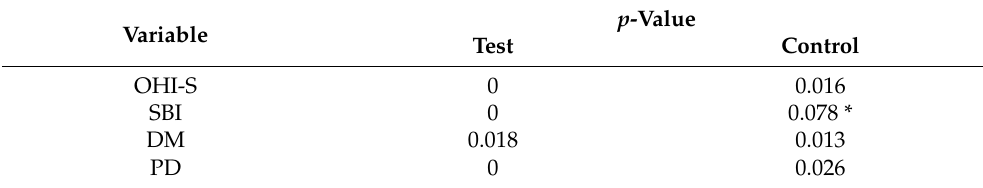
Table 6. Chi-Square test p -values for test differences between both groups (SRP+HBOT and SRP) for all variables. Variable